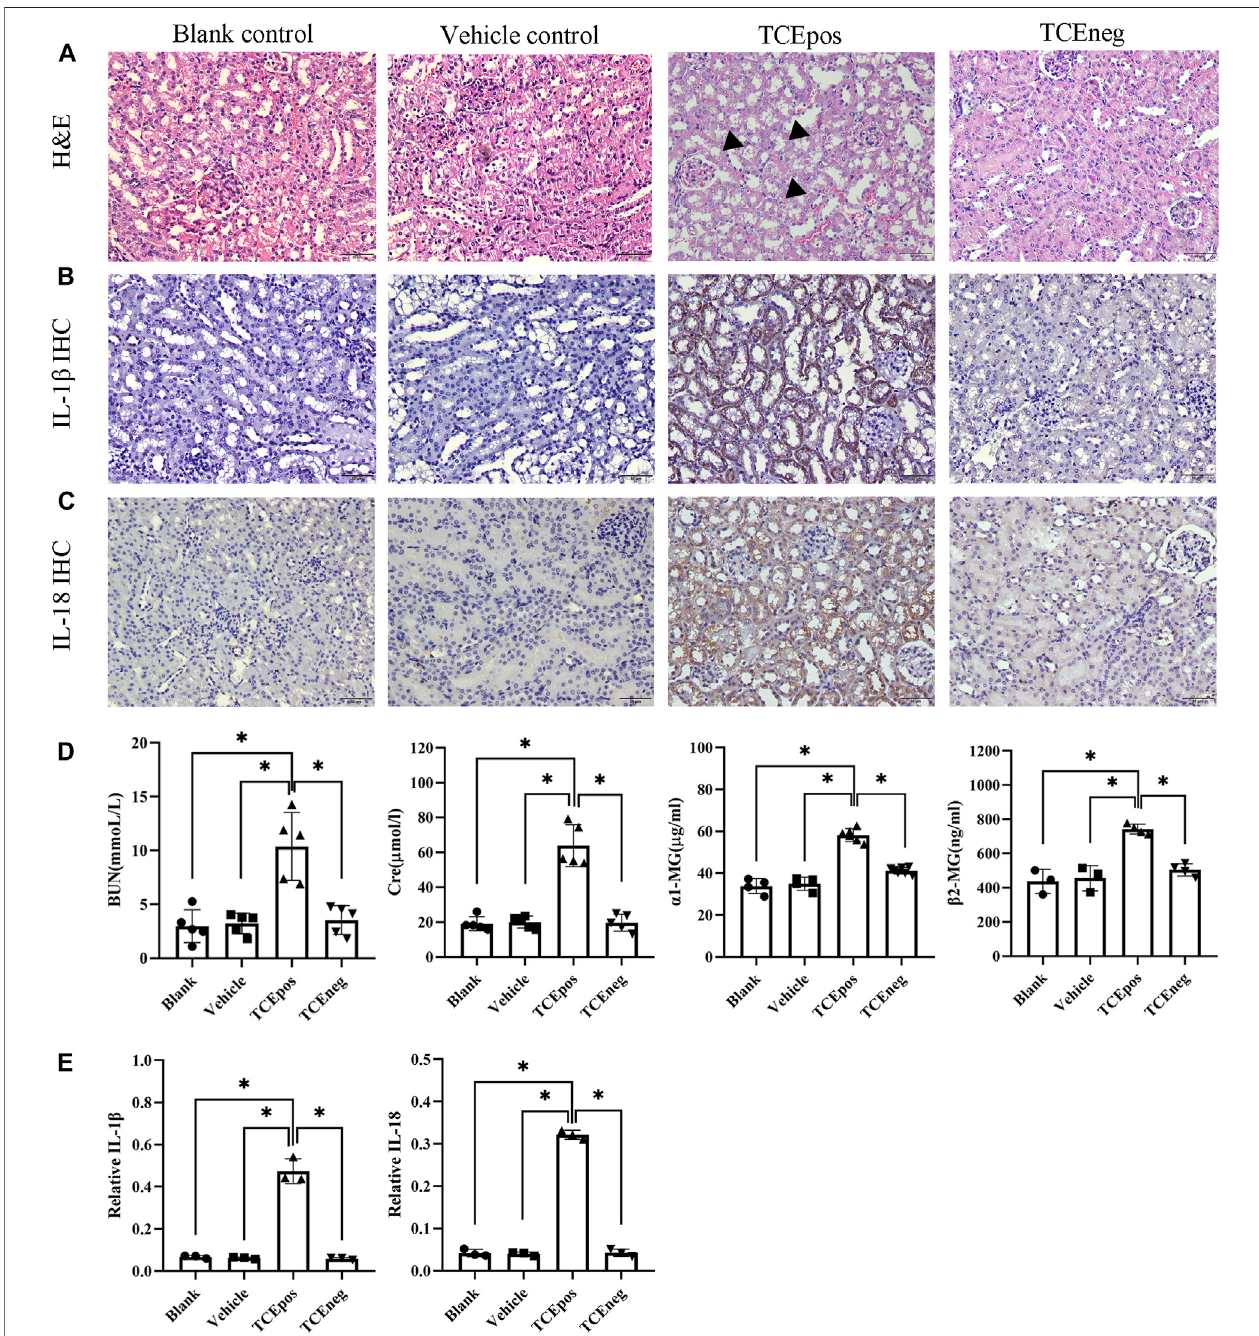
FIGURE 2 | Renal tubular in fl ammatory damage was present in TCE-sensitized mice. (A) Hematoxylin & Eosin (H&E) staining of kidney and (B,C) immunohistochemistry (IHC) of IL-1 β and IL-18 in mice. The black arrow shows tubular swelling, vacuolar degeneration, or detachment of renal tubular epithelial cells. Magni fi cation, ×400. The scale bars represent 50 μ m. (D) Measurement of renal function including the levels of blood urea nitrogen (BUN), creatinine (Cre), α 1 micro- globulin ( α 1-MG), and β 2 micro-globulin ( β 2-MG). (E) Relative expression of IL-1 β and IL-18 was calculated by average optical density in mice. Data are representative of three independent experiments and are expressed as the mean ± SD. n = 3 – 5/group. Levels of signi fi cance were de fi ned as below: * p < 0.05.